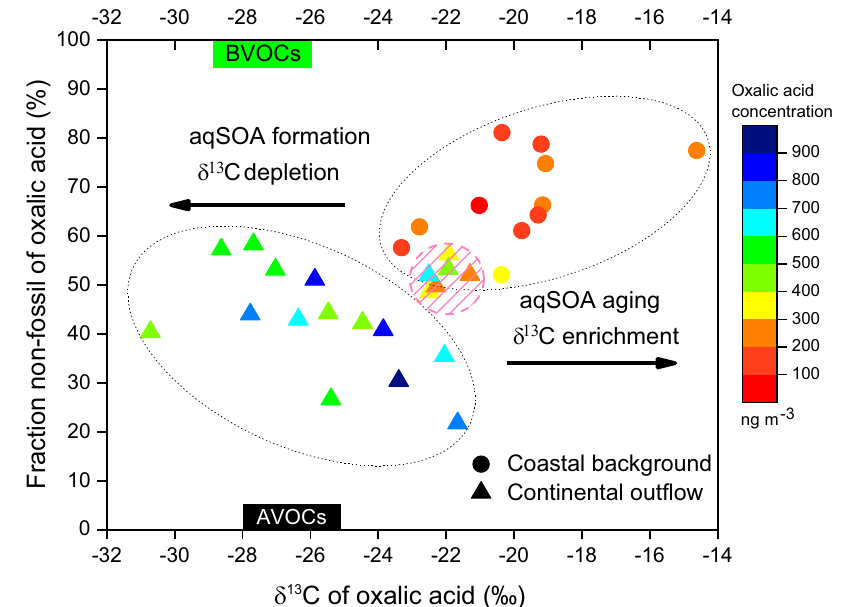
Fig. 5 | Two-dimensional dual-carbon isotope characterization of individual oxalic acid for coastal background and continental out fl ow. The color of the symbols represents the oxalic acid concentration. The δ 13 C source signatures of oxalicacidprecursorgasesfrombiogenicvolatileorganiccompounds(BVOCs;i.e., isoprene) and from anthropogenic volatile organic compounds (AVOCs; i.e.,